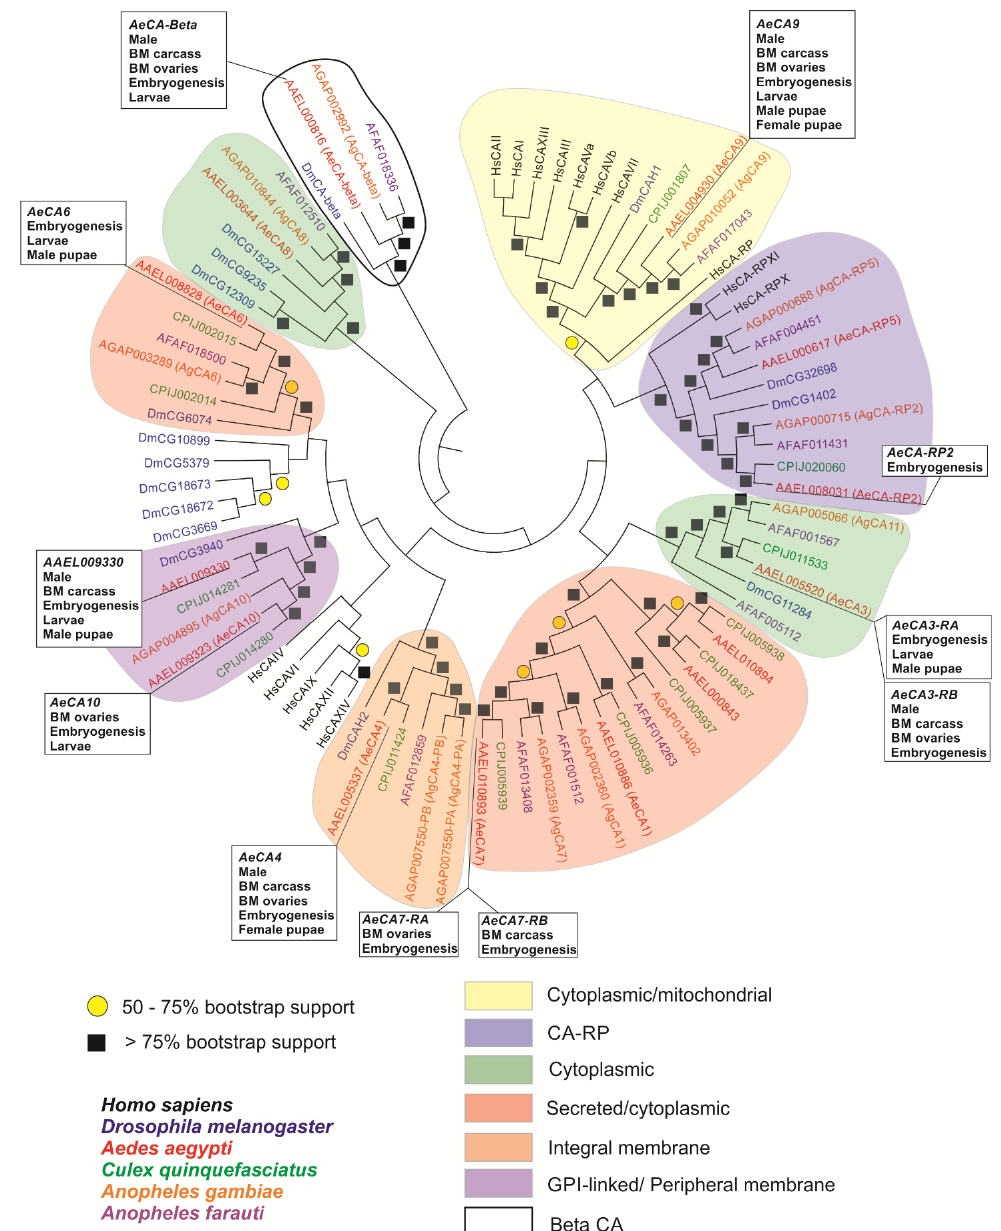
Figure 4. Molecular phylogeny of Aedes aegypti CA isoforms. This maximum likelihood molecular phylogeny was generated using MEGA 6 and based on a MUSCLE alignment of Homo sapiens , Drosophila melanogaster , Aedes aegypti , Culex quinquefasciatus , Anopheles gambiae , and Anopheles farauti . Bootstrap values are represented by yellow circles (50%–75% bootstrap) and black squares (75%–100% bootstrap). Colored bubbles encircle branches of the phylogeny where CAs with similar cellular compartmentalization or structure were grouped together. A legend below the phylogeny shows which color pertains to which compartmentalization/structure. This phylogeny correlates well with the [4] phylogeny and now shows the relationship of Aedes aegypti CAs to Culex quinquefasciatus and Anopheles farauti CAs together with the other species. Finally, the tissue and cellular compartments within which each AeCA was expressed [6] is marked on the phylogeny to correlate RNA expression with the molecular phylogeny. The species color code is as follows: Homo sapiens (black), Drosophila melanogaster (blue), Aedes aegypti (red), Culex quinquefasciatus (green), Anopheles gambiae (orange), and Anopheles farauti (purple).